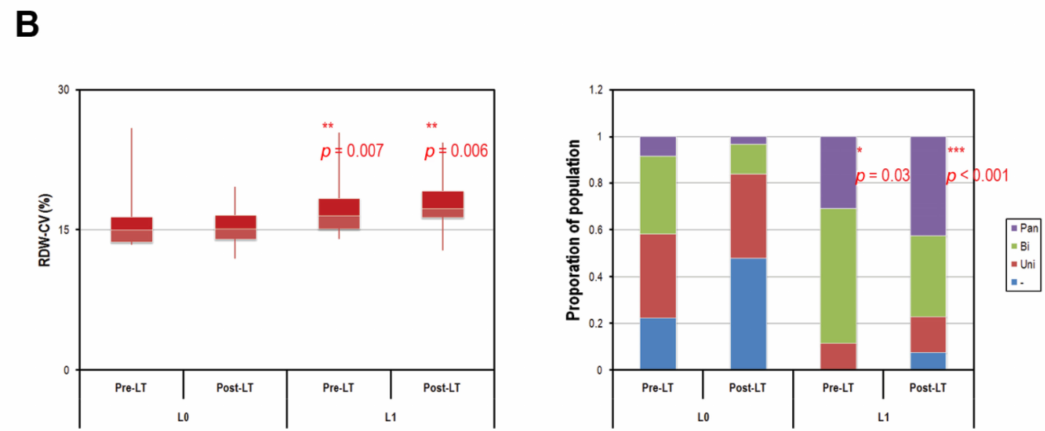
Figure 3. Comparison of pre- and post-transplant lymphocyte counts of HCC patients according to peritransplant NLR values. ( A ) Persistent low lymphocyte counts with a drastically high proportion of severe lymphopenia (<500/ µ L) were observed in peritransplant high NLR patients of HCC. The average 7-day pre- and 30-day post-transplant lymphocyte counts were 1091.5/ µ L and 1137.6/ µ L in control patients versus 536.6/ µ L and 540.5/ µ L in patients of PTH-NLR group, respectively ( p < 0.0001, left panel). The proportions of pre- and post-transplant patients with severe lymphopenia were both less than 12% in control, however, those values were more than 48% (62.1% and 48.3%, respectively) in PTH-NLR group (red box, right panel). ( B ) Patients with persistently severe lymphopenia (PSL) represented increased RDW-CV values (left panel) and significantly larger proportions of pancytopenia (purple box, right panel) compared to the remaining patients (Control). LLN: lower limit of normal (1 × 10 3 / µ L); Pan: pancytopenia; Bi: bicytopenia; Uni: unicytopenia. Significance is established at a p -value of 0.05 by using Mann–Whitney U test (*, ** for p < 0.005, *** for p <